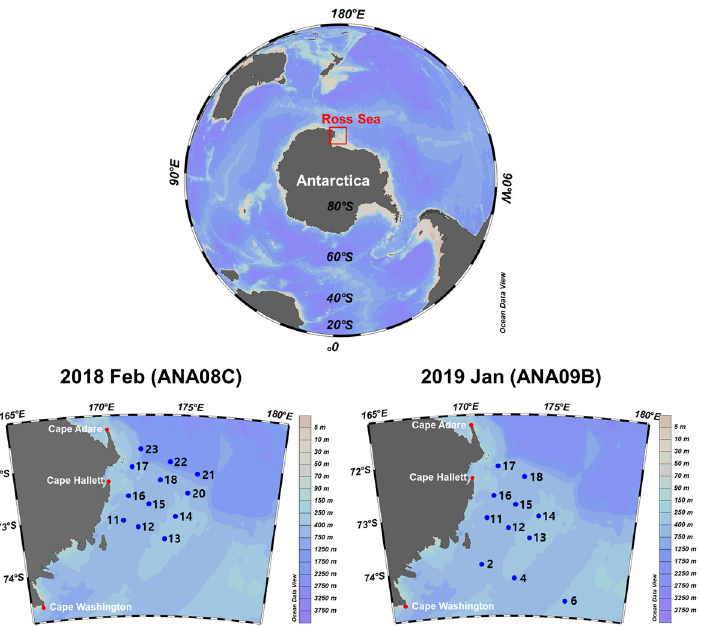
Figure 1. Map of the sampling stations during two IBRV Araon expeditions in the Ross Sea, ANA08C from 26 February to 1 March in 2018 and ANA09B from 16 to 21 January in 2019. Blue dots represent each sampling site in the Ross Sea. Map view created by Ocean Data View software v.5.1.7 (ODV, https://odv.awi.de/, accessed on 23 December 2021).